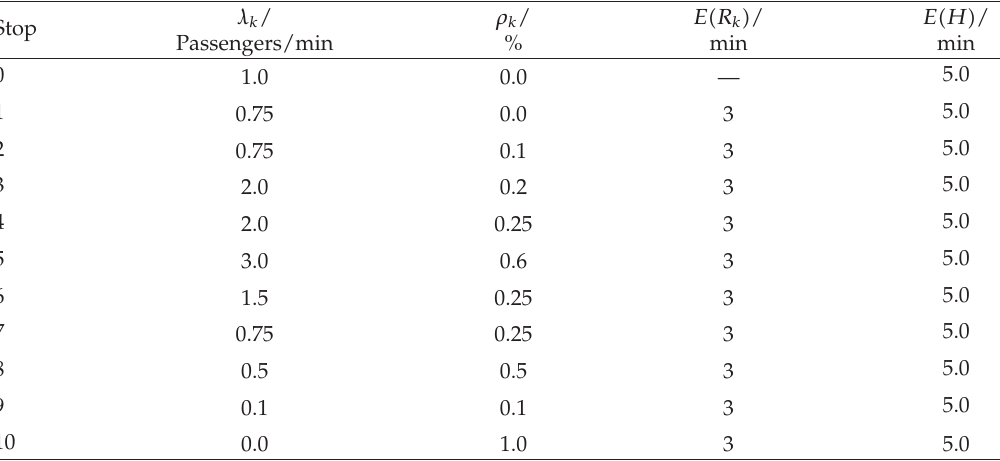
Table 2: Example of bus route